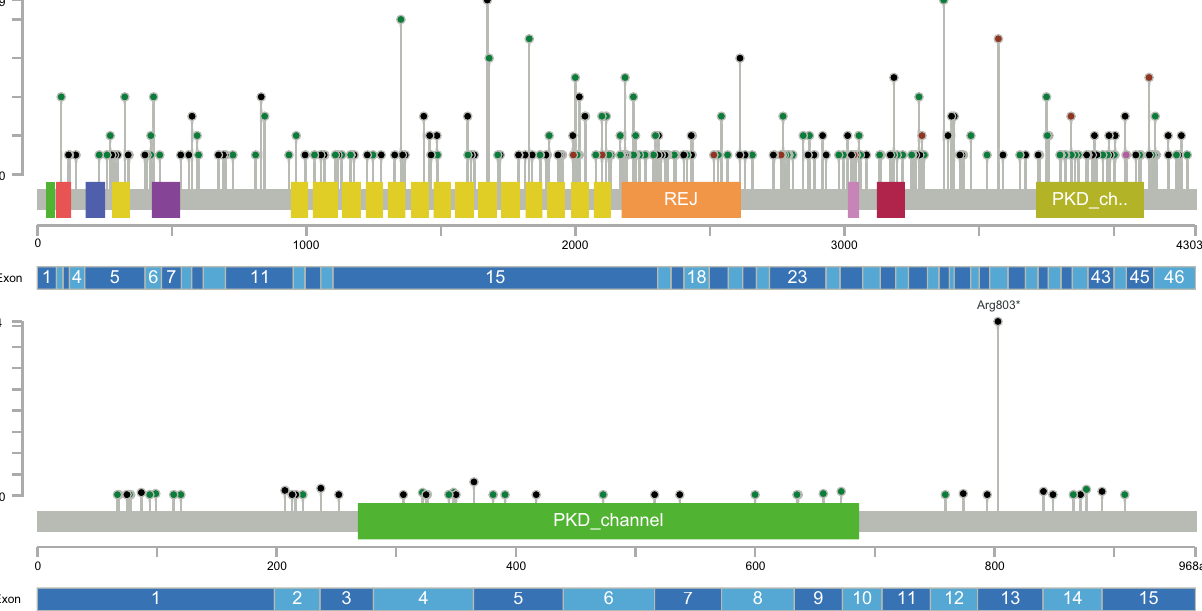
REJREJ PKD_ch..PKD_ch..